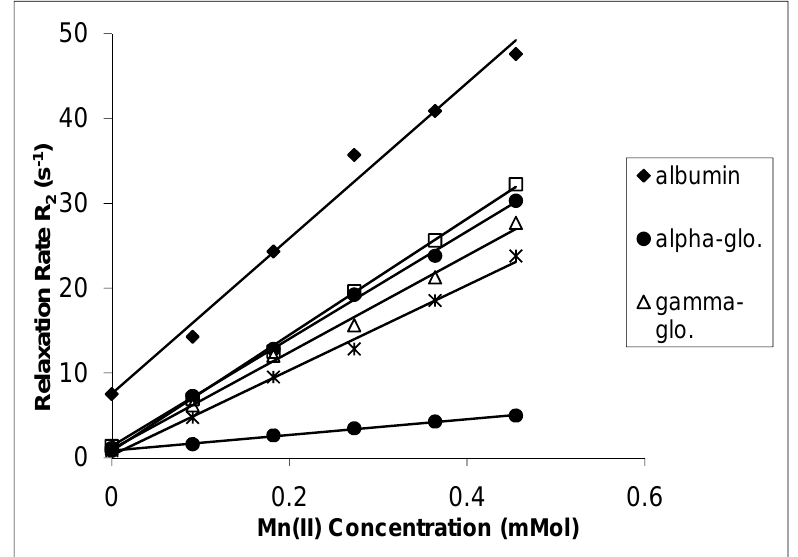
) of protein solutions versus concentration of 2